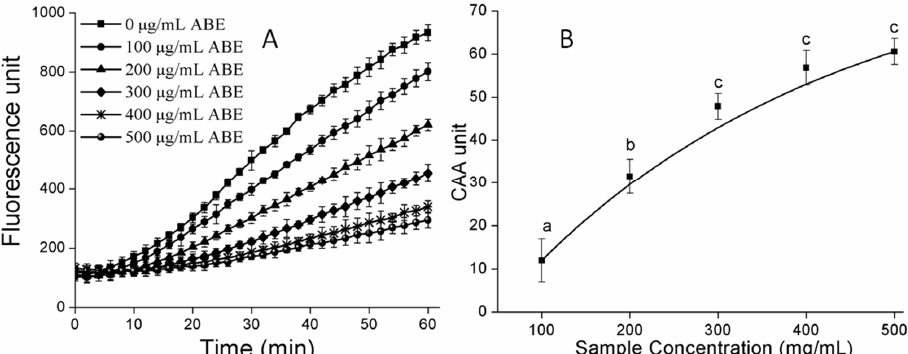
Figure 5. ( A ) Peroxyl radical-induced oxidation of DCFH to DCF in HepG2 cells and the inhibition of oxidation by PAs in ABE over time; ( B ) Dose–response curves for inhibition of peroxyl radical- induced DCFH oxidation by ABE. Values labeled with the same letter (a–c) are not significantly different from each other ( p < 0.05). The symbols represent mean ± SD.